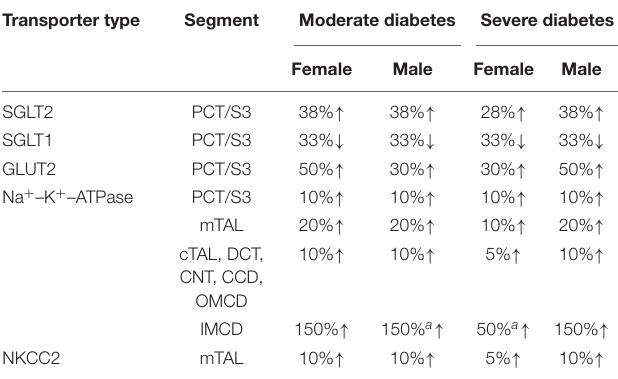
TABLE 1 | Up- ( ↑ ) or downregulation ( ↓ ) of transporter activity in moderate and severe diabetes. Transporter